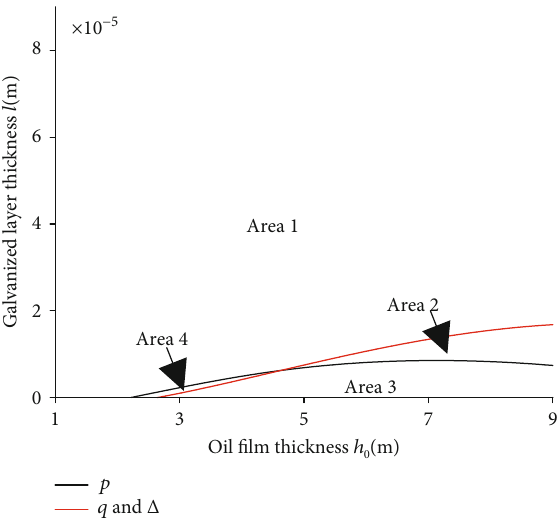
Figure 12: Positive and negative boundary of p , q , and △